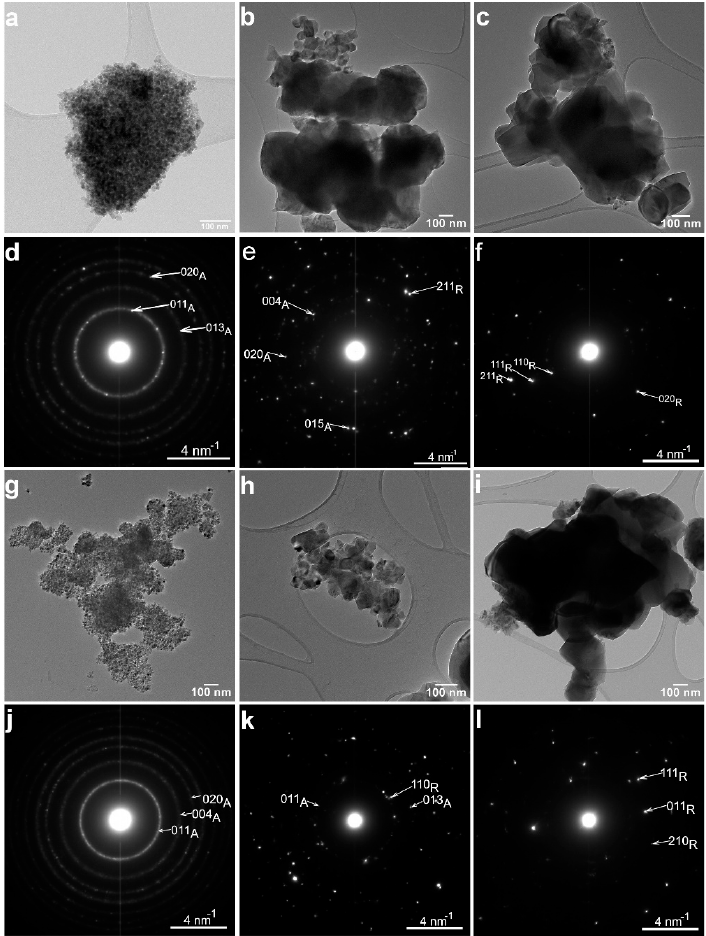
Figure 2. Low-magnification TEM images and the corresponding electron diffraction patterns for the white samples: ( a , d ) T400W, ( b , e ) T550W, ( c , f ) T800W; for the black samples: ( g , j ) T400B, ( h , k ) T550B, ( i , l ) T800B. The letter “A” from the indexed diffraction patterns stands for “anatase”, while the letter “R” stands for “rutile”.